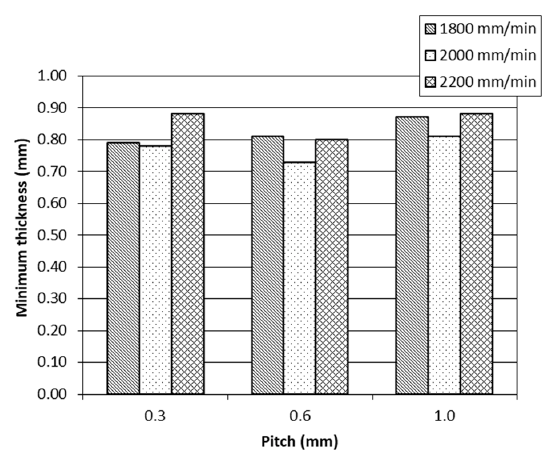
Figure 7. Minimum thickness obtained in the different tests.